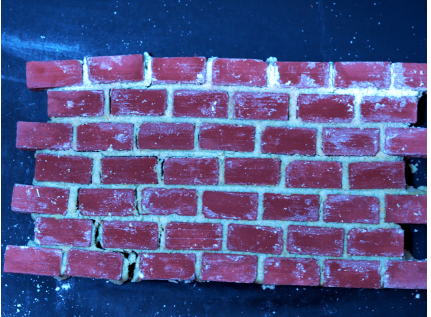
Figure 1. A sample image of wall built and cracked in the